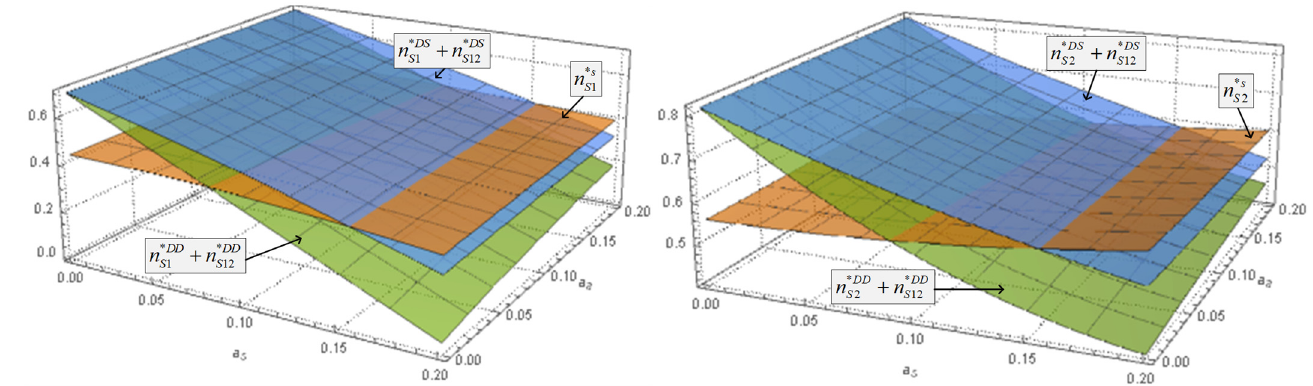
Figure 5. The impacts of network effect on the number of subscribers in three cases.